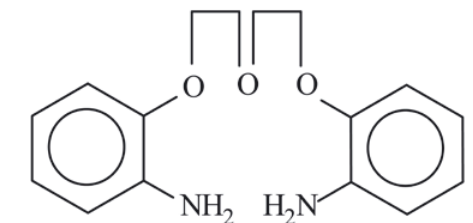
Figure 1 . Structure of bis-(2-ortho-aminophenoxyethyl)ether ( 1